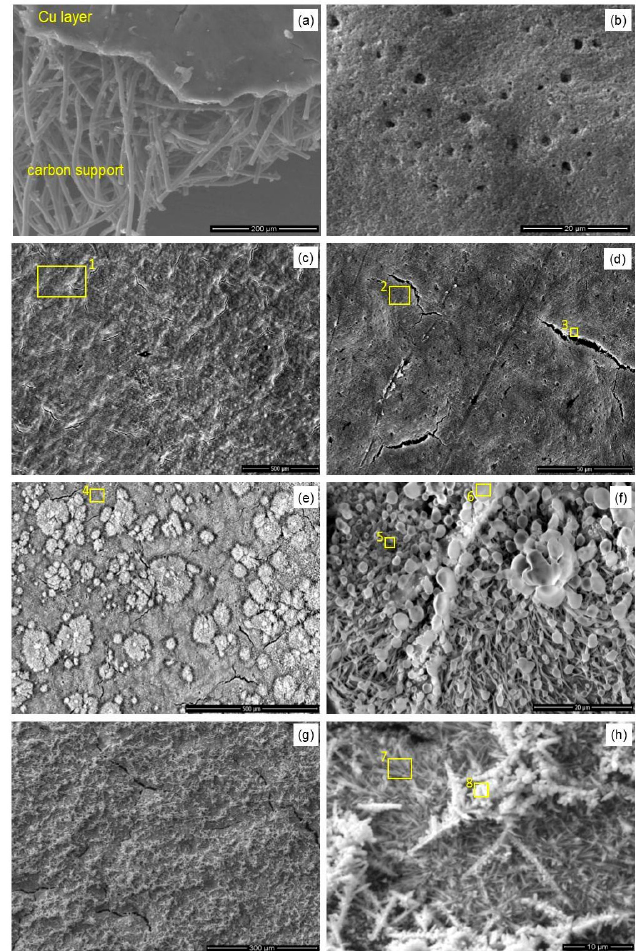
Figure 5. SEM images of Cu 100 nm sputtered on Freudenberg H23C2 carbon paper before the process ( a , b ), after 1-h test in 1M KHCO 3 ( c , d ), after 1-h test in 1M KHCO 3 with a single addition of 1 mL of copper lactate solution, ( e , f ), and after a test with a series of copper lactate injections ( g , h ) (200 mA·cm − 2 ). See Table. S1 in ESI for the details of EDS analyses of labeled areas.